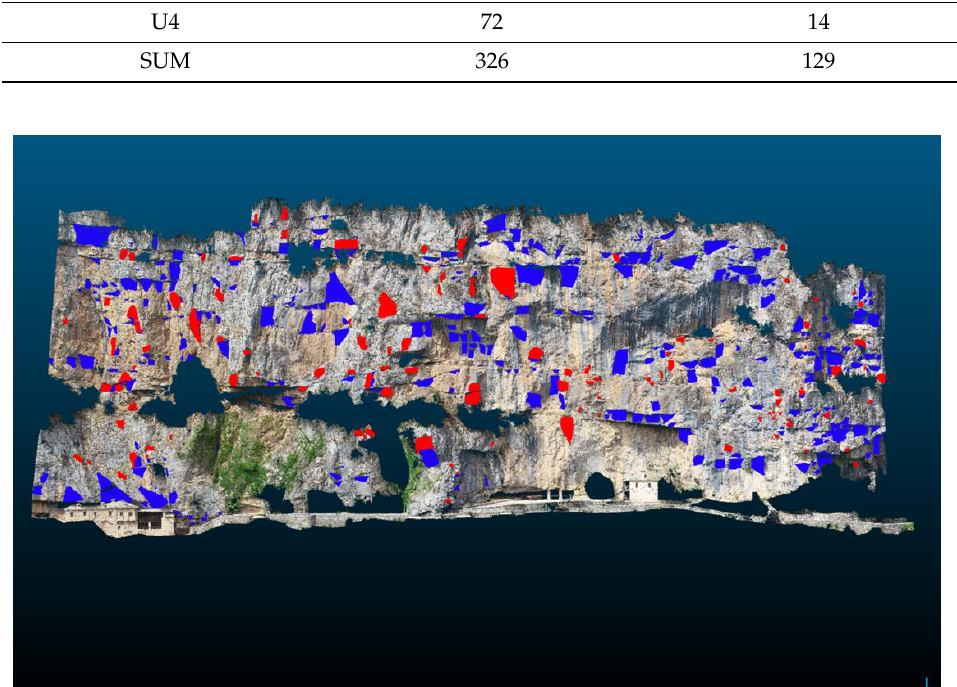
Figure 14. Overview of both the already failed (blue) and the potentially unstable (red) blocks in the whole